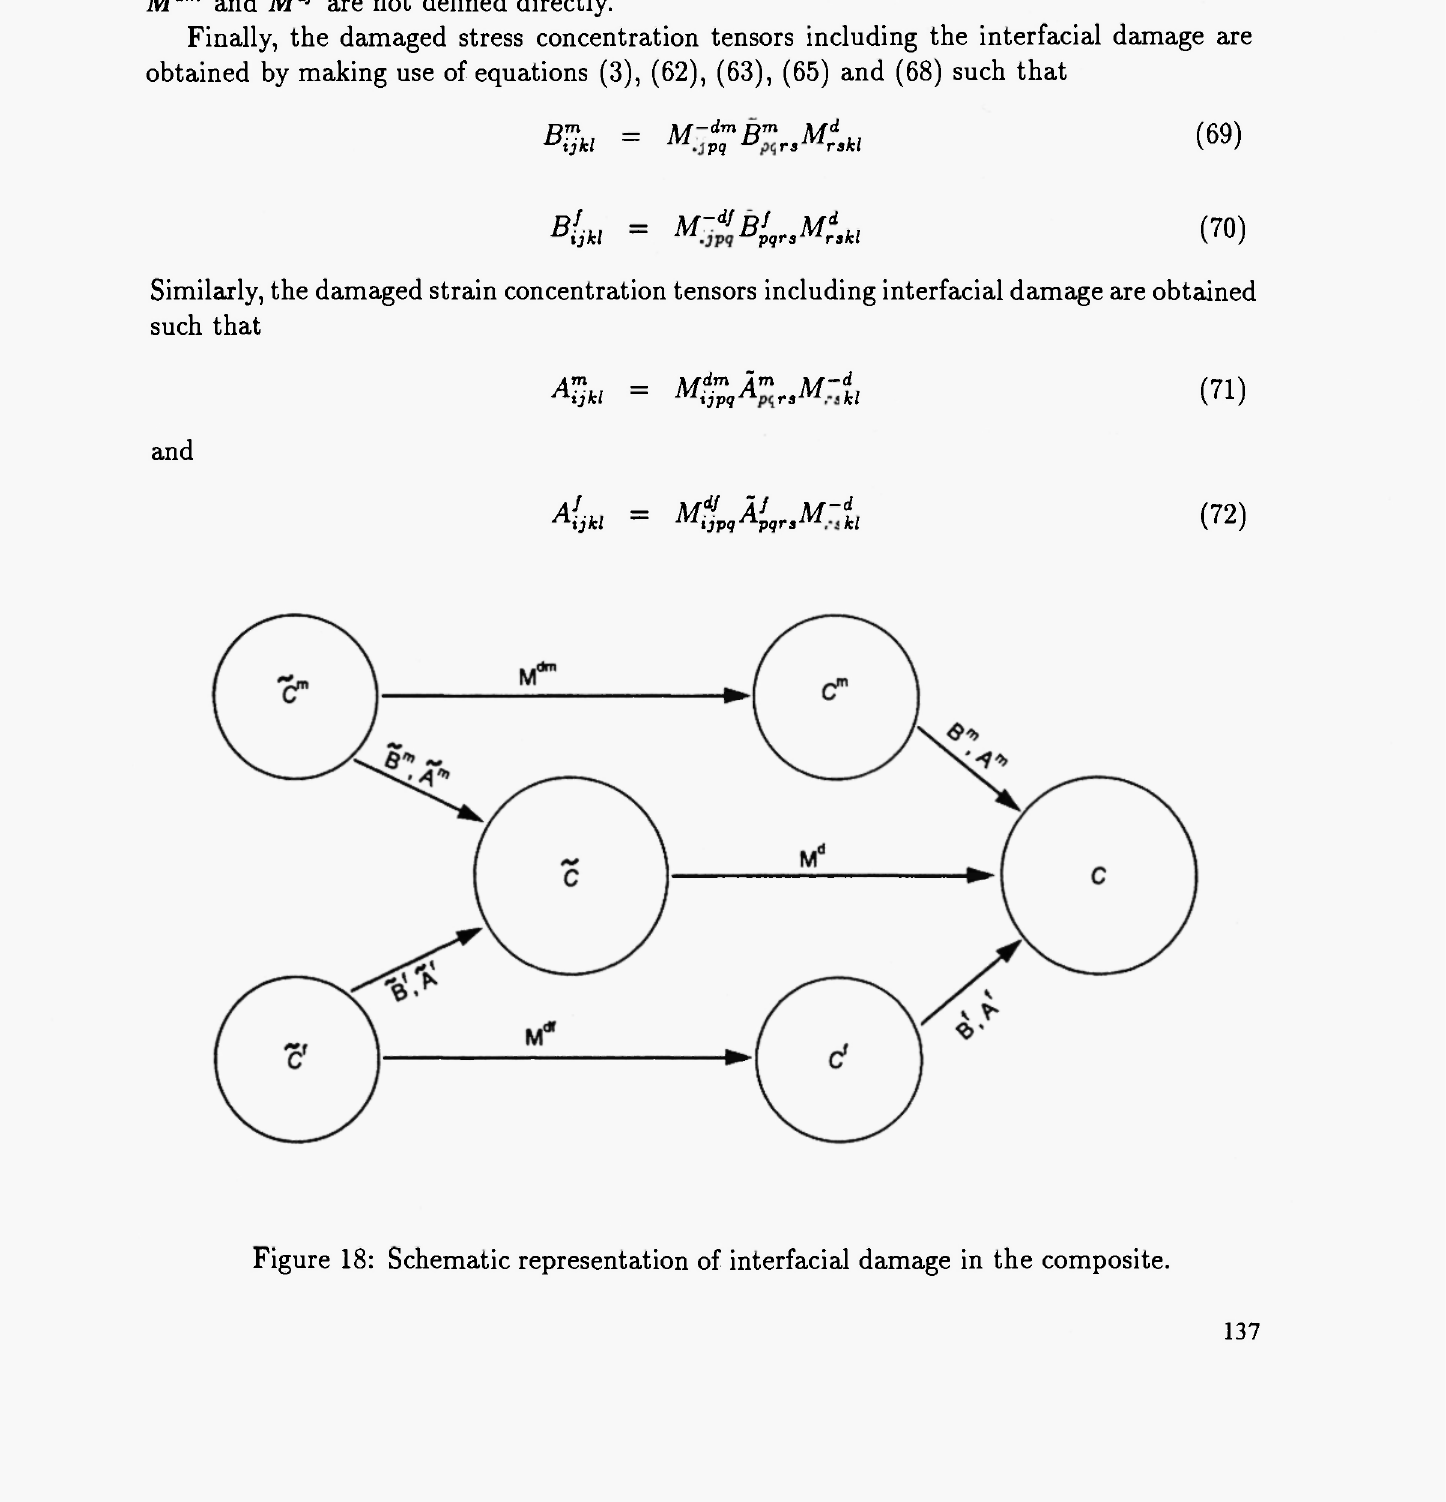
Figure 18: Schematic representation of interfacial damage in the